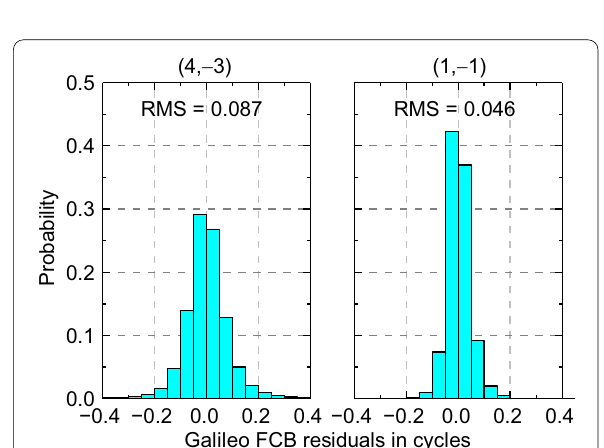
0.40.0 −0.4 −0.2 0.0 0.2 Fig. 4 Histogram of the Galileo FCB residuals in the NL and WL linear